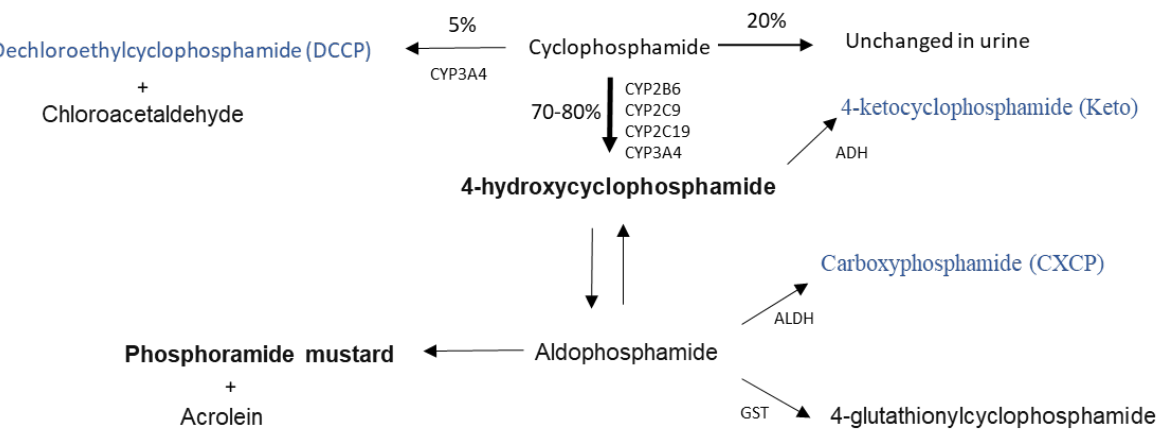
Figure 1. Cyclophosphamide metabolic pathway (adapted from Jonge et al., 2005 [7]). Active metabolites are bold, metabolites measured in this study are blue. CYP; Cytochrome P450, ADH; Alcohol dehydrogenase, ALDH; aldehyde dehydrogenase, GST; Glutathione-S-transferase.